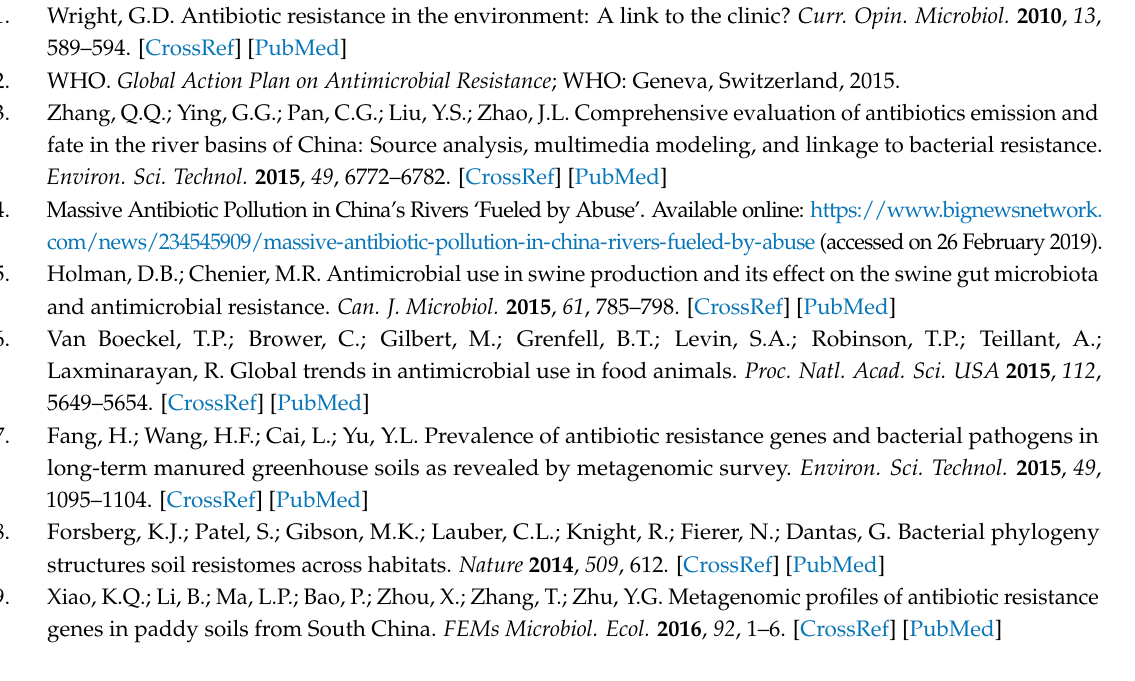
Table S1: Primer list of antibiotic resistance genes in this study. Author Contributions: Conceptualization, Y.L. and H.Y.; methodology, Y.L.; software, Y.L. and H.L.;